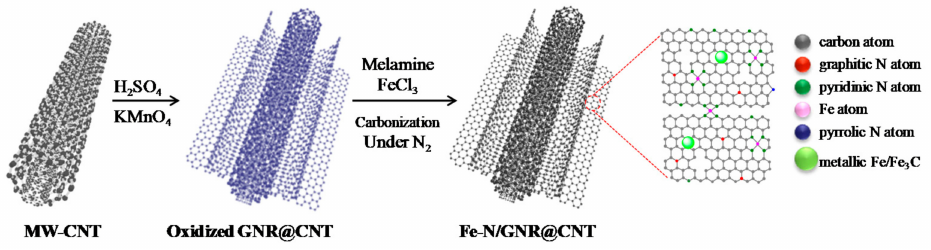
Figure 1. Illustration of the preparation process for Fe-N co-doped graphene nanoribbon@carbon nanotube (GNR@CNT